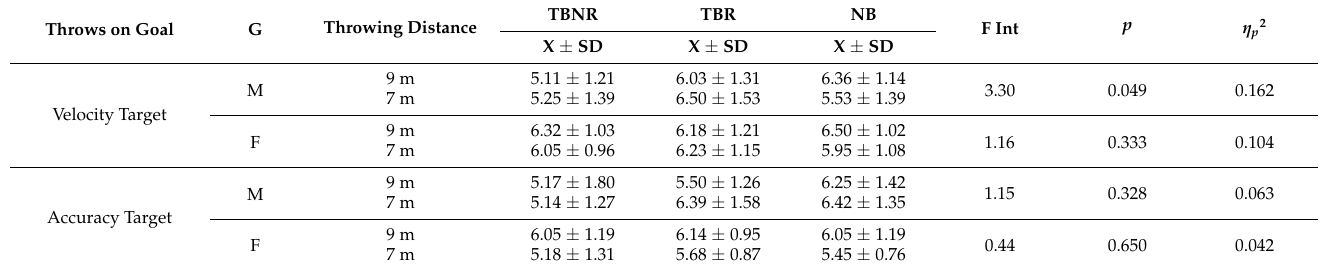
Table 1. Male and female players’ perception level of throwing velocity (Likert scale 1–10) according to throwing distance (7 and 9 m), ball type (traditional ball with no resin—TBNR; traditional ball with resin—TBR; and new ball—NB) and instruction received (velocity and accuracy